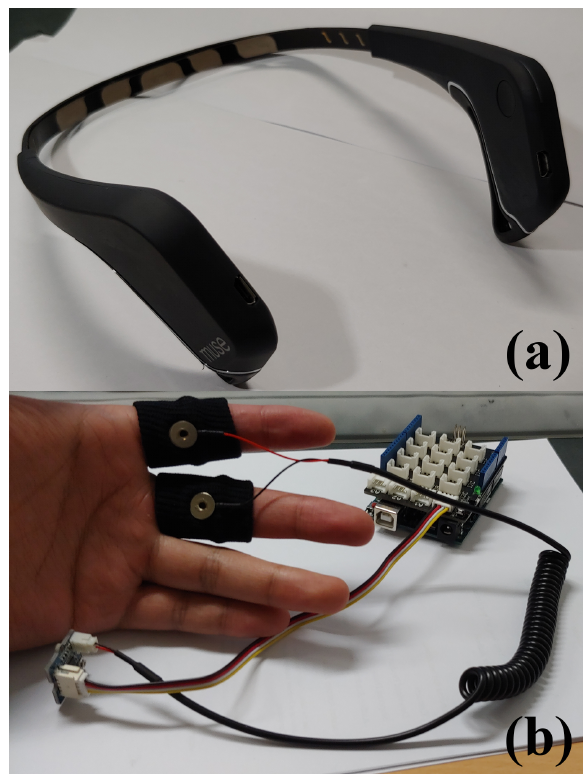
Figure 2. ( a ) EEG sensor, and ( b ) GSR